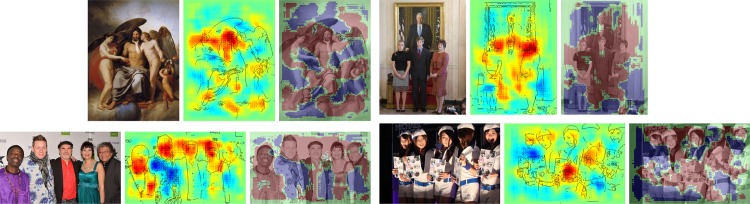
Pixel-wise decomposition for Bag of Words features over a histogram intersection kernel using the layer-wise relevance propagation for all subsequent layers and rank-mapping for mapping local features.Each triplet of images shows—from left to right—the original image, the pixel-wise predictions superimposed with prominent edges from the input image and the original image superimposed with binarized pixel-wise predictions. The decompositions were computed on the whole image. Faces below the hairline but also hands yield high scores, see the woman in the third picture which turns away her face from the camera as an example that hair alone is not relevant. Images by Pelagio Palagi, Wikimedia users Rorschach, Frankie Fouganthin and Flickr user Le vent dans les dunes.